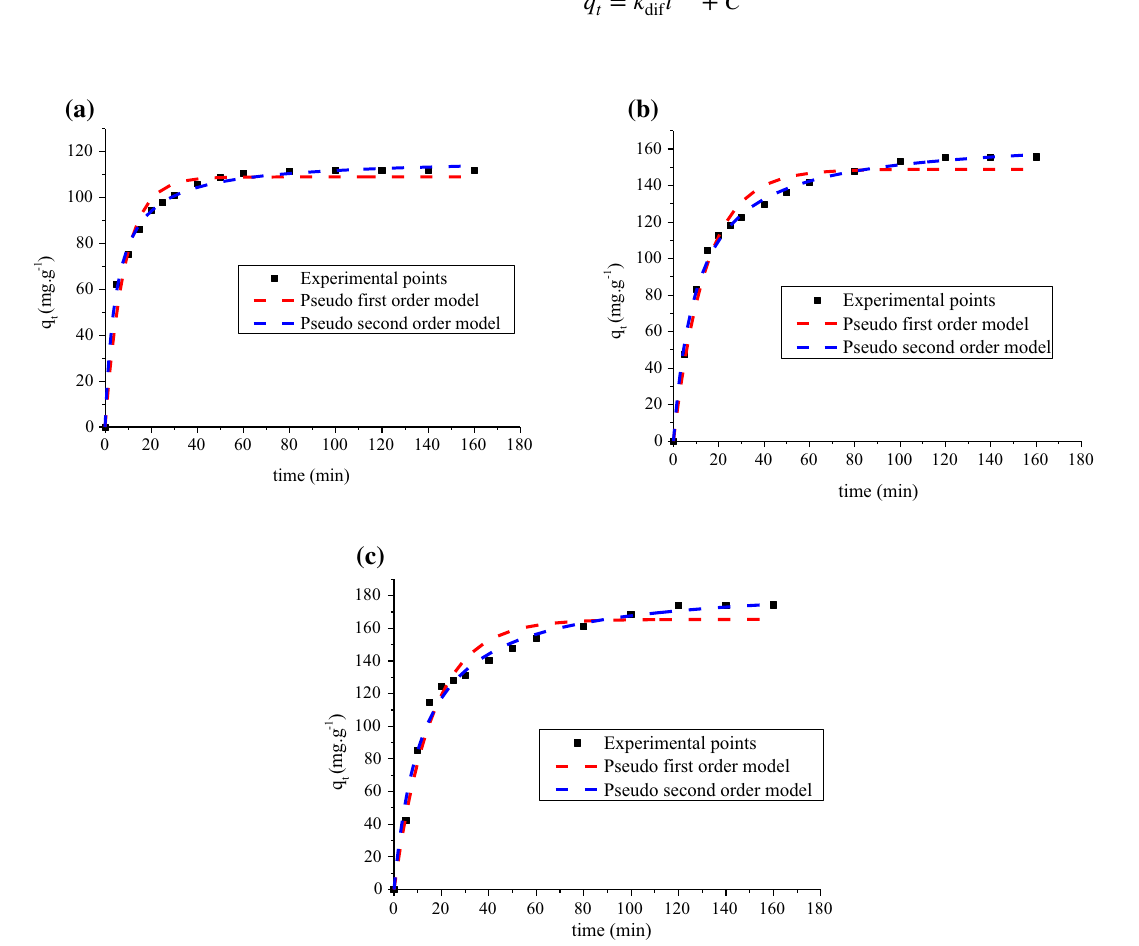
Fig. 7 Pseudo-first-order and pseudo-second-order models of AB25 adsorption onto WDS-AC at different concentrations a 90 mg L −1 ; b 130 mg L −1 ; c 150 mg L −1